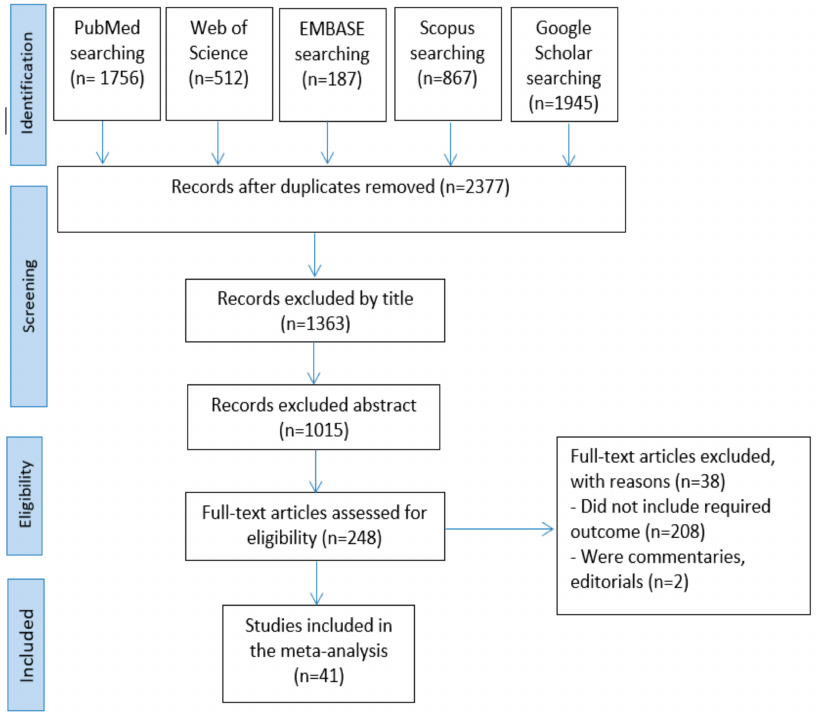
Figure 1. Articles selection